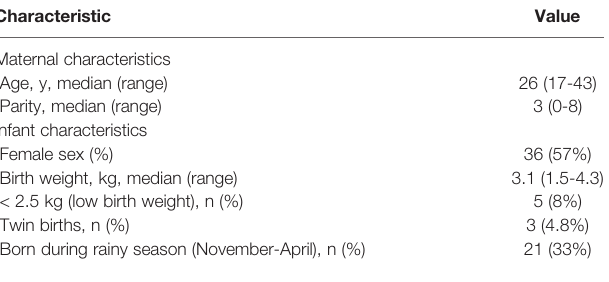
TABLE 1 | Baseline characteristics of 63 participating mother-infant pairs. Characteristic